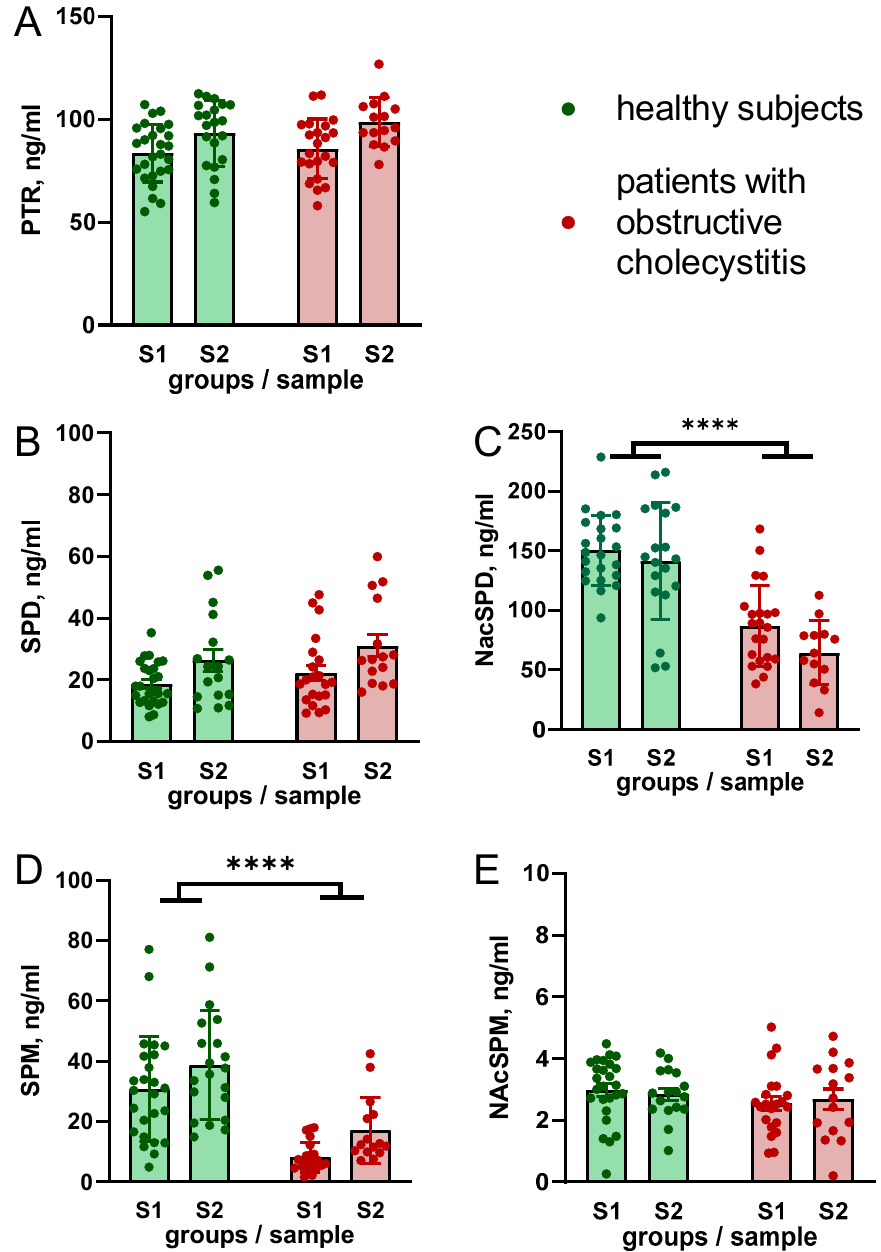
Figure 3. Profile of plasma polyamines in healthy subjects and patients with cholecystitis and liver cirrhosis. Comparison of plasma levels of ( A ) putrescine (PTR); ( B ) spermidine (SPD); ( C ) N 1 Ac spermidine (NAcSPD); ( D ) spermine (SPM); ( E ) N 1 Ac spermine (NAcSPM) in healthy and patients with obstructive cholecystitis. S1—Before cholecystectomy/first blood sample; S2—after cholecystectomy/second blood sample. ****— p < 0.0001. Obstructive cholecystitis appeared as a significant factor changing NAcSPD and SMP plasma levels (two-way ANOVA: pathology × sample, F (1,46) = 62.64, p < 0.0001, Figure